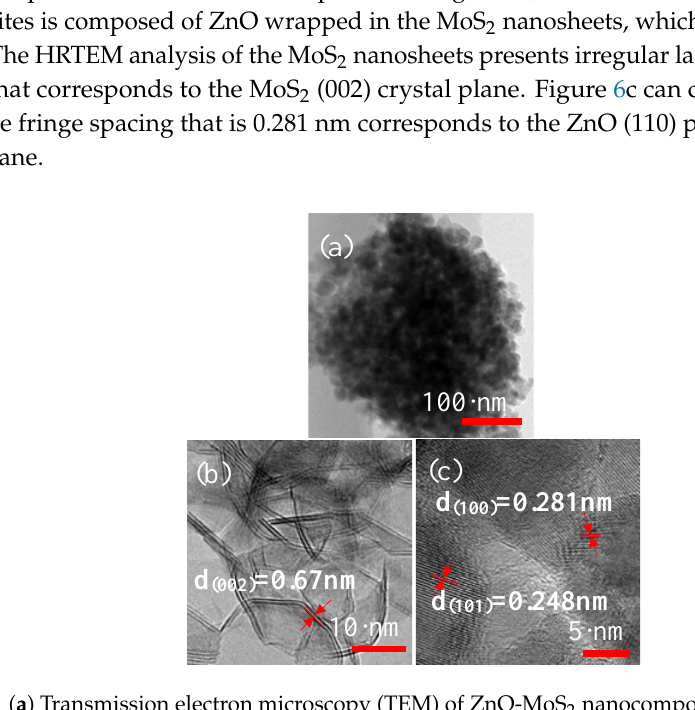
Figure 6. ( a ) Transmission electron microscopy (TEM) of ZnO-MoS 2 nanocomposite S3. ( b ) HRTEM of MoS 2 and ( c ) ZnO particles